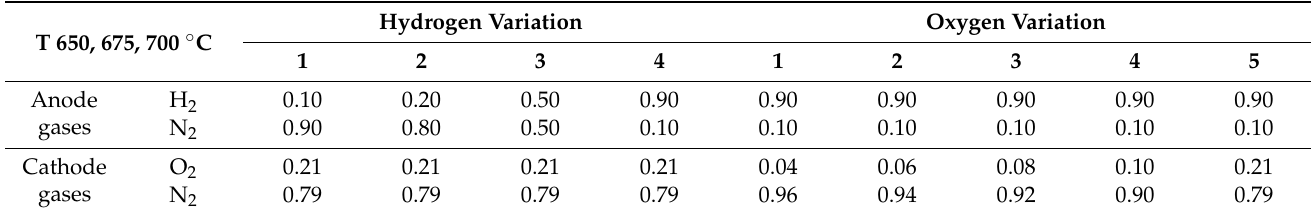
Table 2. The gas composition of different measurement stages in molar